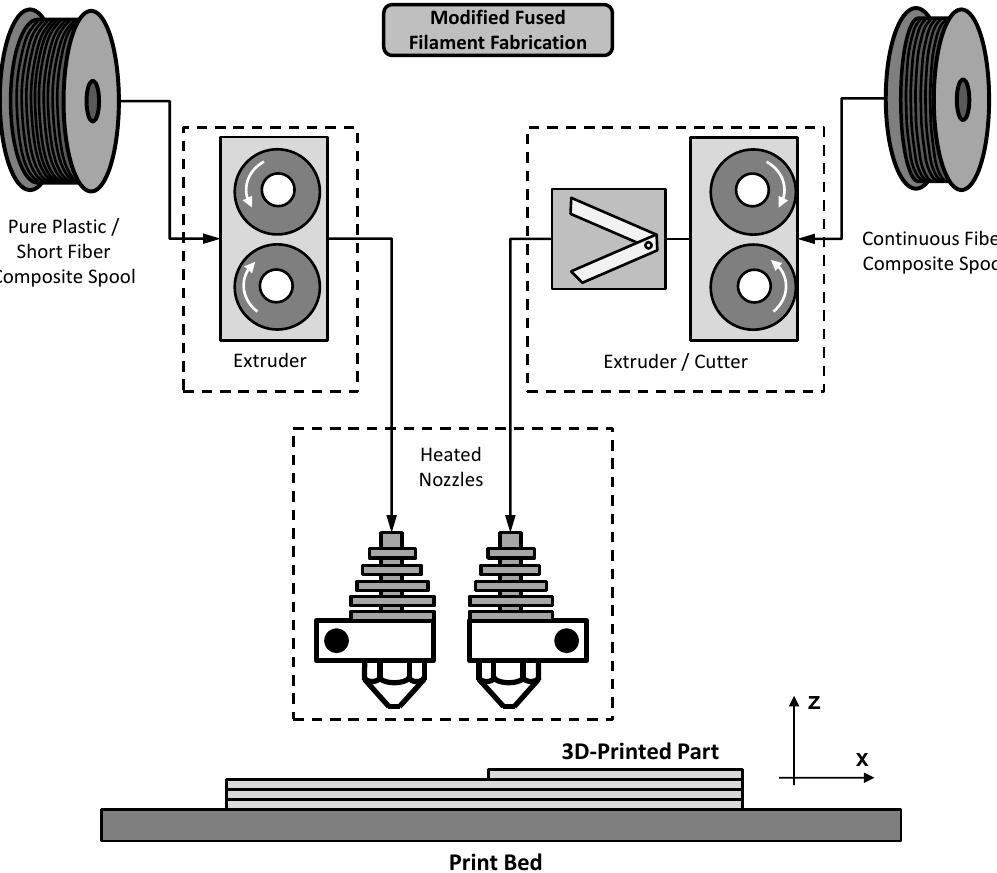
Figure 2. Schematic view of modified FFF process which is able to use unreinforced filaments or chopped fiber reinforced filaments (typical extrusion system) and continuous fiber reinforced filaments (specific extrusion and cutting